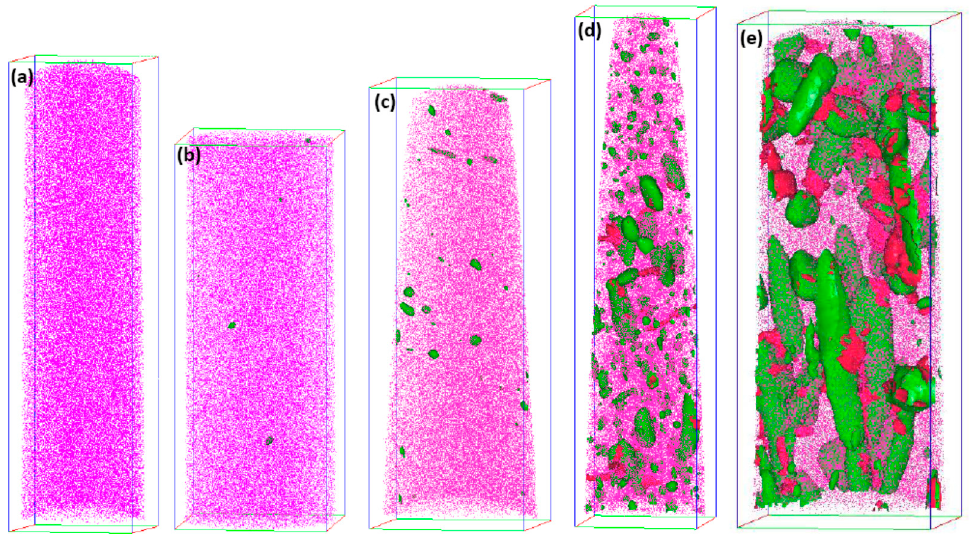
Figure 6. Three-dimensional reconstruction of the atomic positions of Fe ( purple pints ) and isoconcentration surface for regions containing more than 35 at % Ni + Ti ( green surfaces ) and 5 at % Mo ( red surfaces ) for specimens ( a ) aged for 10 min; ( b ) aged for 0.5 h; ( c ) aged for 4 h; ( d ) aged for 40 h; ( e ) aged for 100 h. Bounding box size: ( a ) 58 × 59 × 218 nm 3 ; ( b ) 55 × 55 × 144 nm 3 ; ( c ) 64 × 65 × 182 nm 3 ; ( d ) 59 × 60 × 247 nm 3 ; ( e ) 67 × 69 × 173 nm 3 .